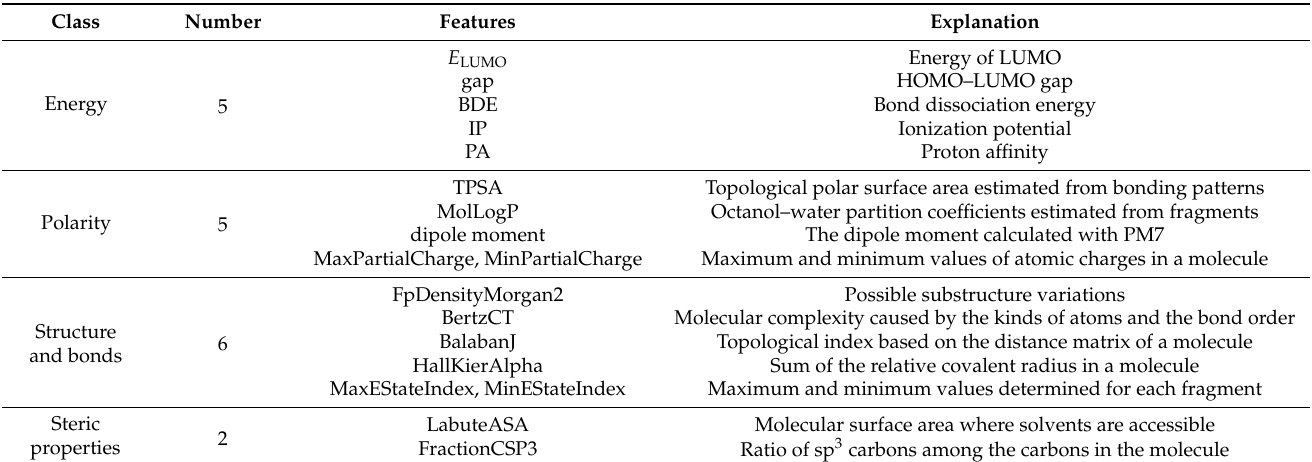
Table 2. Selected 18 common features in this study. Features in the energy class and dipole moment were calculated with PM7. Other features were obtained from